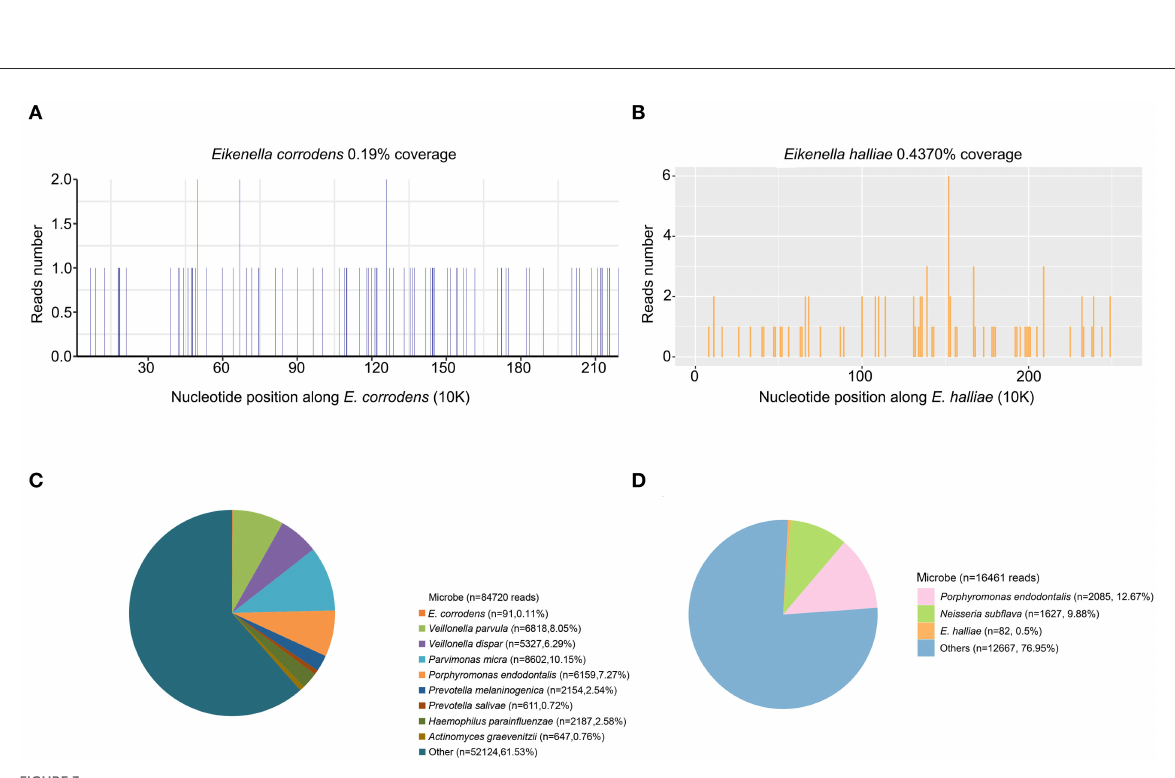
FIGURE3 The metagenomic next-generation sequencing (mNGS) results of this patient. The coverages of Eikenella corrodens by the first mNGS and Eikenella halliae by the second mNGS are shown in (A,B) respectively. The detected specific read numbers and the percentages of E. corrodens and E. halliae are shown in (C,D) ,